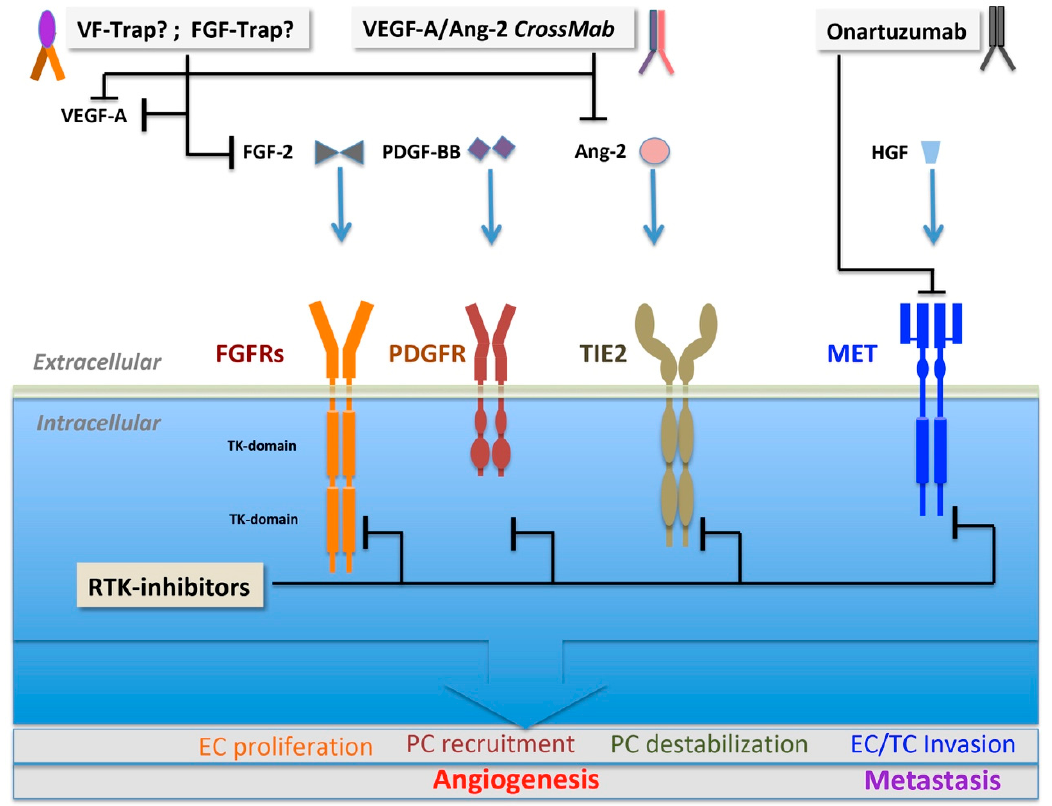
Figure 3. Alternative angiogenic pathways playing a role in tumor angiogenesis, refractoriness, evasive resistance or relapses in response to anti-VEGF monotherapies and tools available for targeting their e ff ects. Resistance to anti-angiogenic therapy might be mediated by angiogenic factors that trigger a switch from an initially VEGF-dependent state to a VEGF-independent angiogenic process. In order to interfere with these alternative pathways, besides the small molecule multikinase inhibitors (RTK-inhibitors) blocking down-stream signal cascade activation even in the presence of receptor occupancy, several recombinant biological tools have been developed. The range of these tools includes decoys (“ligand traps”) aimed at withdrawing alternative pro-angiogenic factors either alone (fibroblast growth factor (FGF)-Trap) or simultaneously with VEGF-A (VF-Trap), engineered multivalent monoclonals (CrossMabs) or antibody tools raised against RTK receptors blocking the access of ligands to their cognate receptor (onartuzumab). Abbreviations: EC, endothelial cell; PC, pericyte; TC, tumor cell; Ang-2, angiopoietin-2; FGF-2, fibroblast growth factor-2; FGFR, fibroblast growth factor receptor; HGF, hepatocyte growth factor; MET, mesenchymal-epithelial transition proto-oncogene; PDGF, platelet-derived growth factor; PDGFR, platelet-derived growth factor receptor; TIE2, Tyrosine kinase with immunoglobulin-like and EGF-like domains 2; RTK, receptor tyrosine